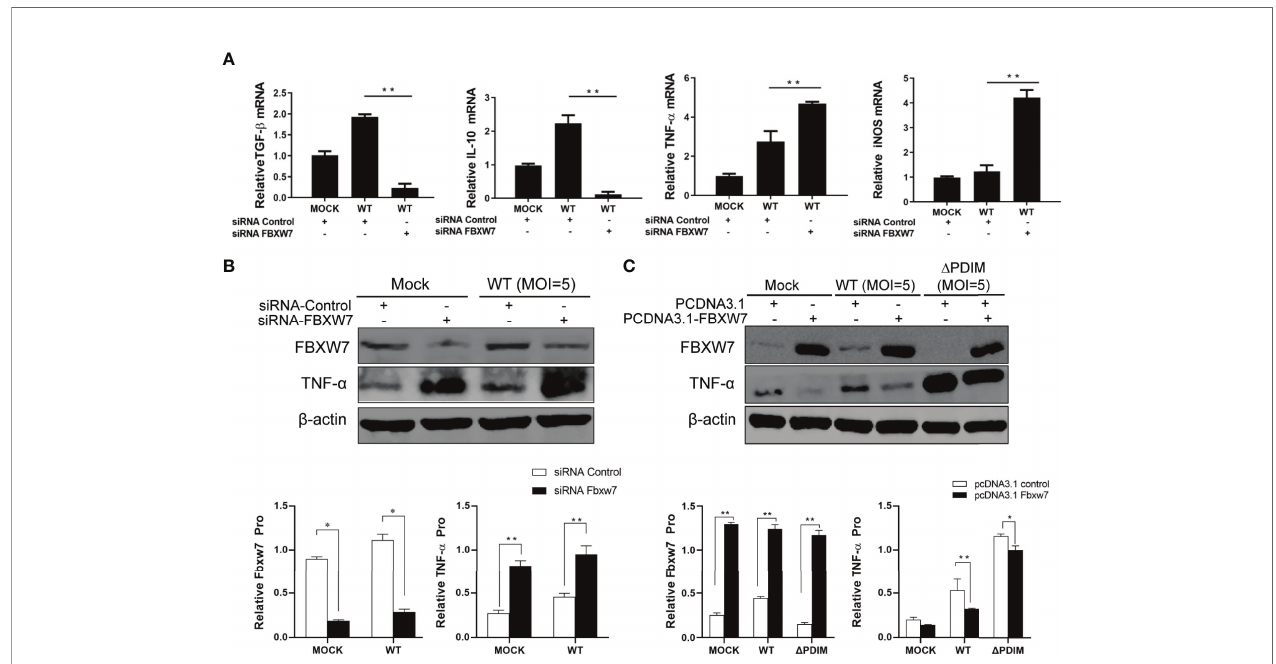
FIGURE 3 | FBXW7 in fl uences the expression of in fl ammatory mediators in Mm infection. (A, B) Raw264.7 cells were transfected with FBXW7 mimic (siRNA- Control) or FBXW7 inhibitor (siRNA-FBXW7) for 24 h, which was followed by infection with Mm at 5 MOI for 4 h or mock infection treatment. The expression of pro- and anti-in fl ammatory mediators were detected by q RT-PCR (A) and Western blot (B) . TGF-ß and IL-10 mRNA expression were down-regulated by FBXW7 silencing in Mm infected cells. TNF- a mRNA and protein and iNOS mRNA expression were up-regulated by FBXW7 silencing in Mm infected cells. (C) Raw264.7 cells were transfected with PCDNA3.1 or PCDNA3.1_FBXW7 for 24 h, which was followed by infection with wild type Mm or △ PDIM strains at 5 MOI for 4 h. The expression of TNF- a was detected by Western blot. b -actin was used as an internal control. All the data in the histograms represent the mean ± standard deviation SD. * P < 0.05 and ** P < 0.01. All the experiments were repeated three times with similar